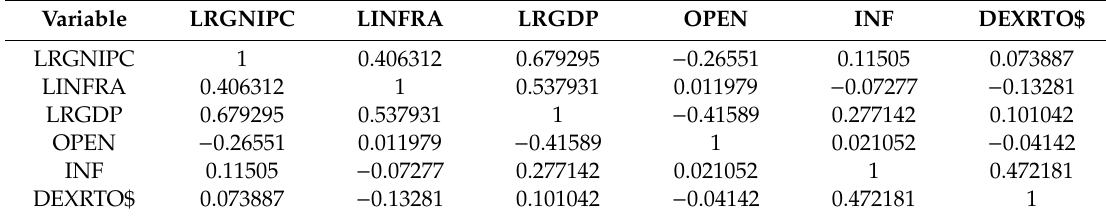
Table 4. Correlation between the independent variables. Source: Authors’